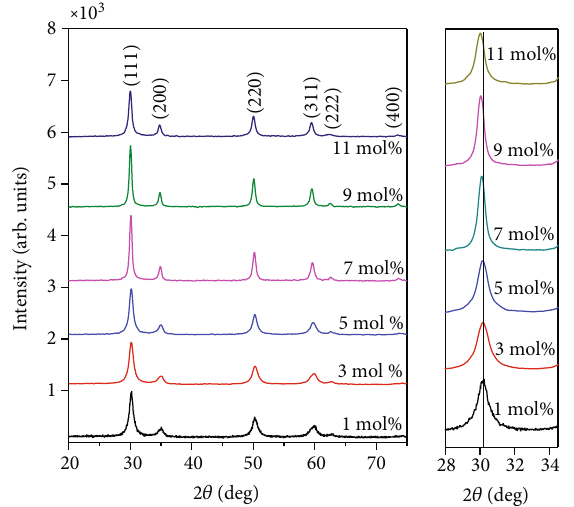
Figure 1: X-ray di ff raction pattern of Dy 3+ -doped (1-11mol%) ZrO 2